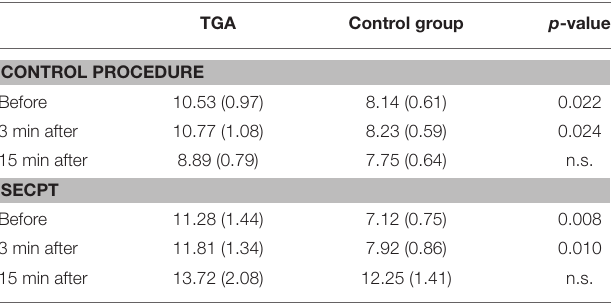
TABLE 2 | Cortisol response during the SECPT and the control procedure in TGA individuals vs. healthy controls. TGA Control group p